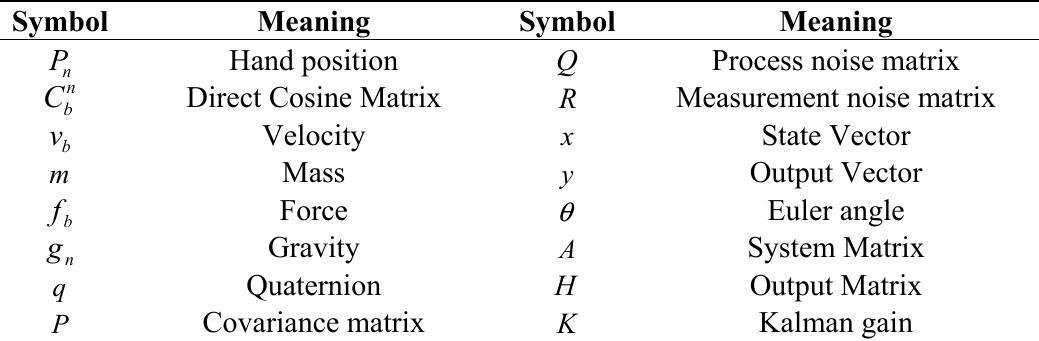
Table 2. Symbols used for